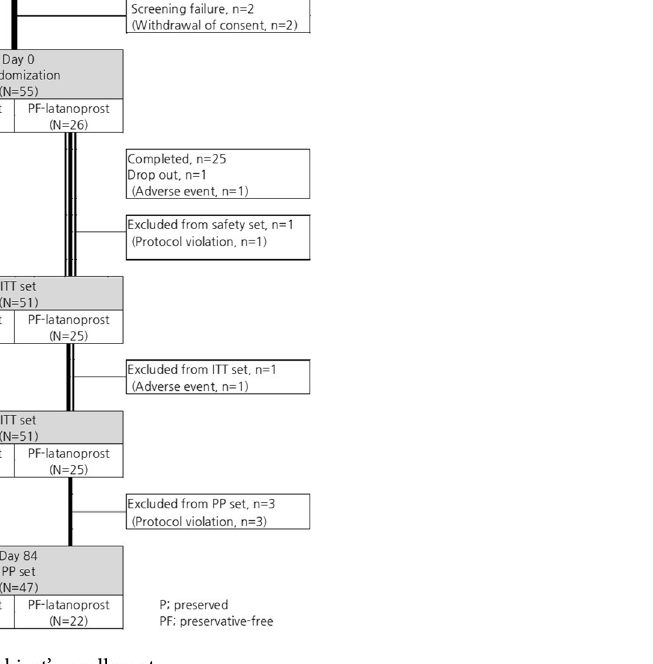
Figure 1. Flow chart of the subject’